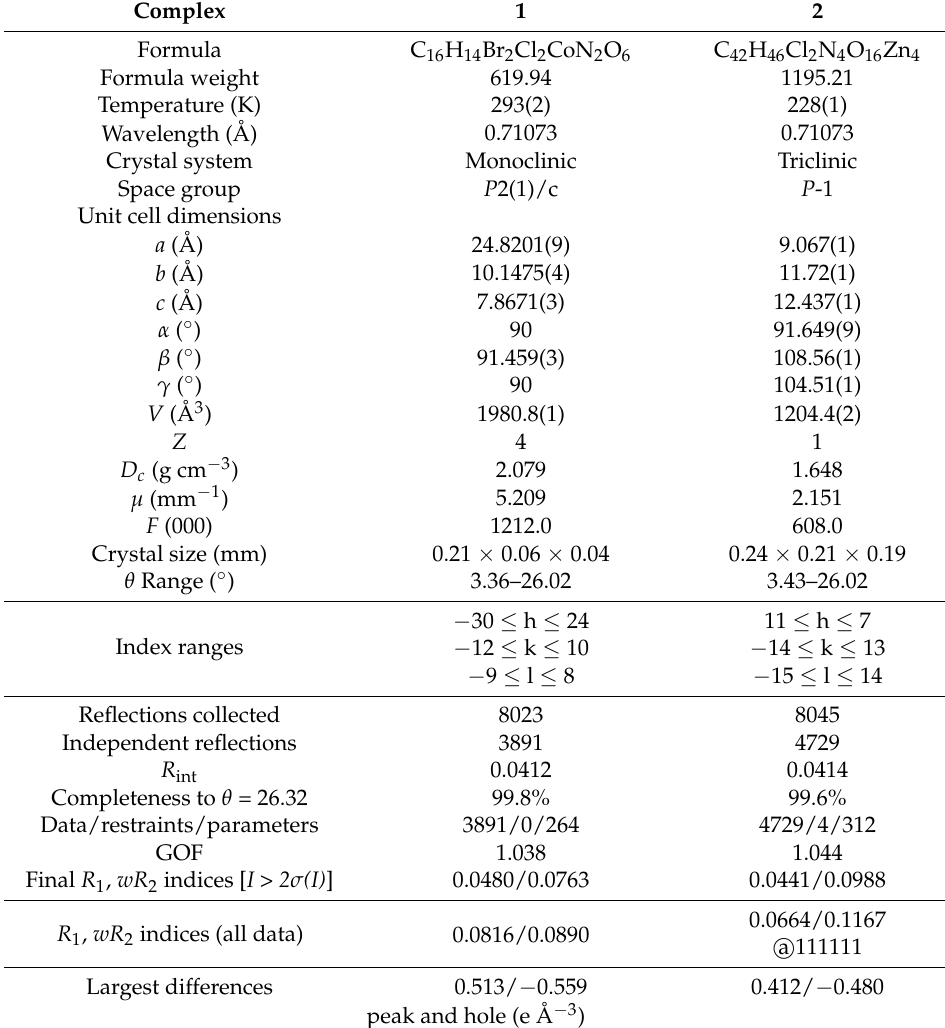
Table 1. Crystal data and structure refinement parameters for complexes 1 and 2